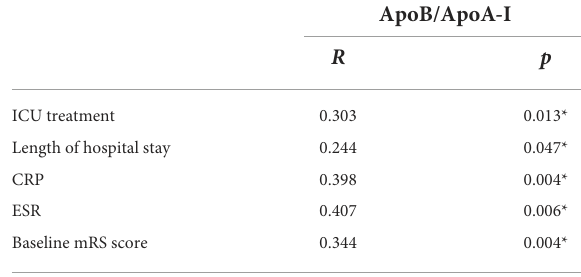
TABLE 4 Correlation analysis of factors related to ApoB/ApoA-I ratio in patients with anti-NMDAR encephalitis.